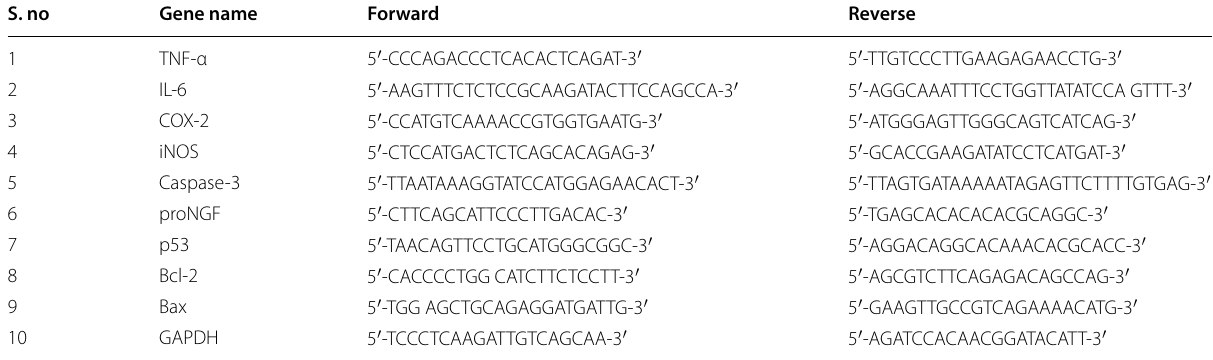
Table 1 List of RT-PCR primers used for the amplification of TNF-α, IL-6, COX-2, iNOS, caspase-3, proNGF, p53, bax and bcl-2 S.